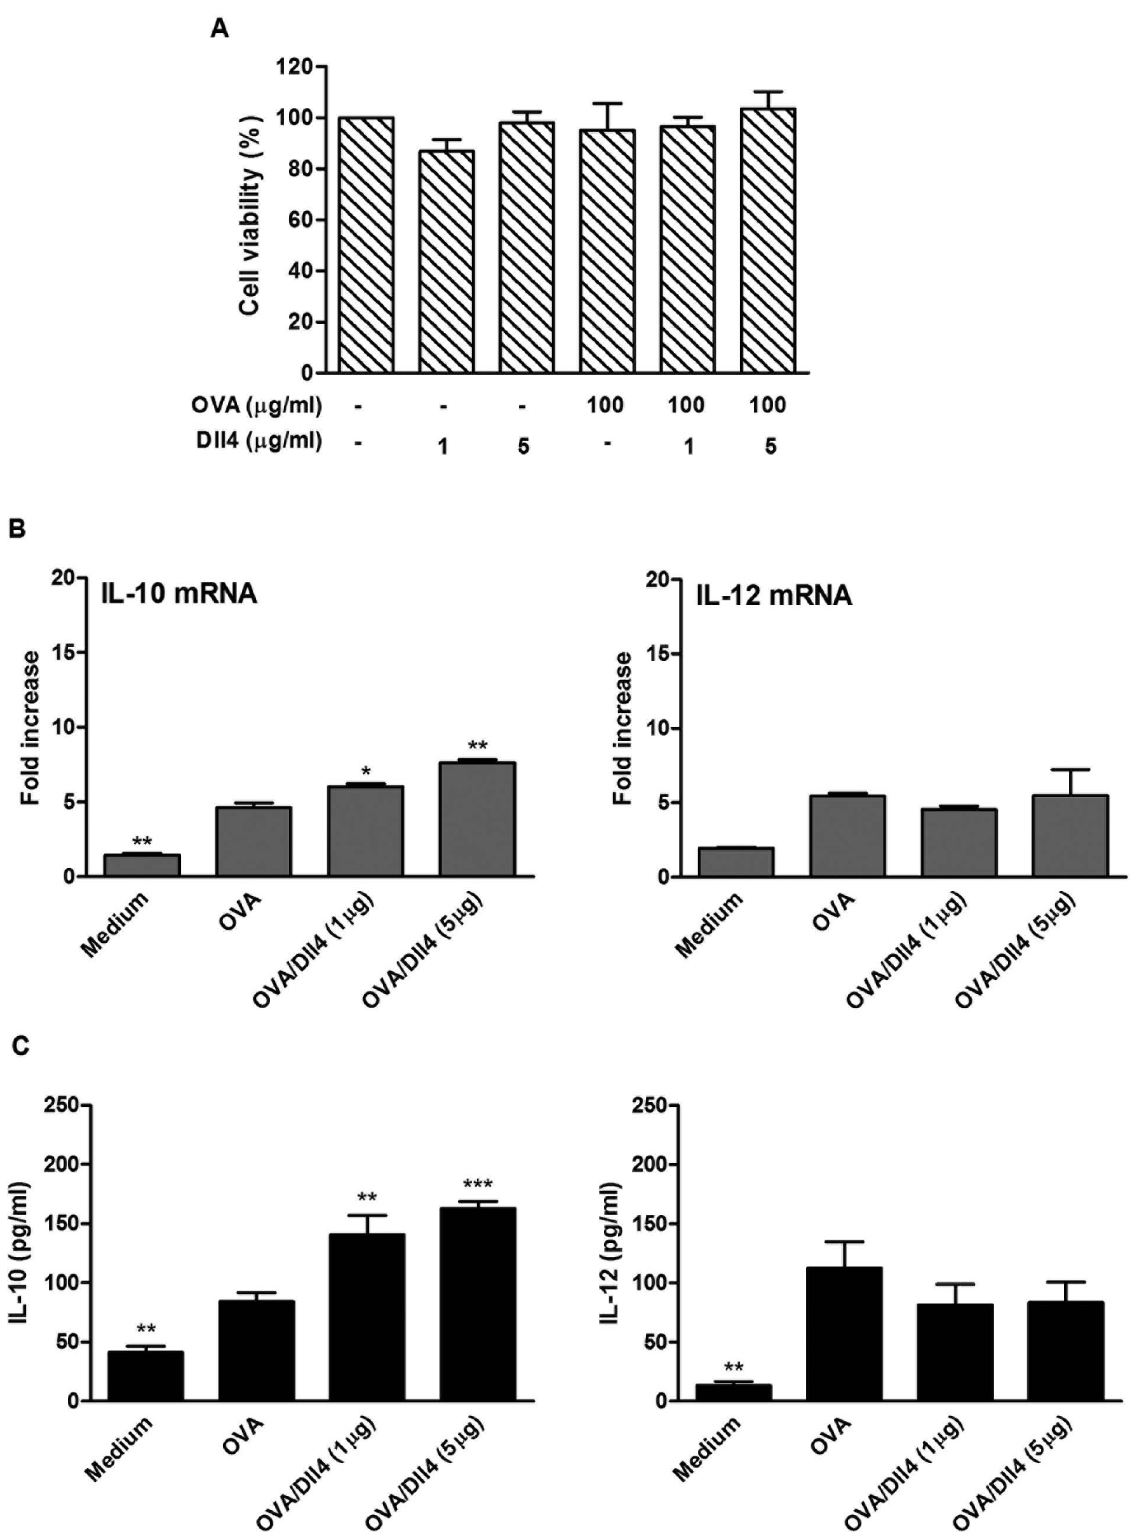
Figure 1. Interleukin-10 expression is upregulated following ovalbumin stimulation in Dll4-pretreated dendritic cells. (A) Cytotoxicity effect of Dll4 on dendritic cells. On Day 4 of culture, bone marrow-derived dendritic cells (DCs) were treated with 1 and 5 m g/mL of Dll4 for 48 h, then cultured with or without 100 m g/mL ovalbumin (OVA) for an additional 24 h. Cell viability was detected using an MTT assay. Untreated DCs were pulsed with OVA or medium alone as the controls. (B) Interleukin (IL)-10 and IL-12 mRNA expression and (C) protein levels from various doses of Dll4- pretreated DCs with OVA stimulation. On Day 4 of culture, bone marrow-derived DCs were treated with medium or various concentrations of Dll4 (1